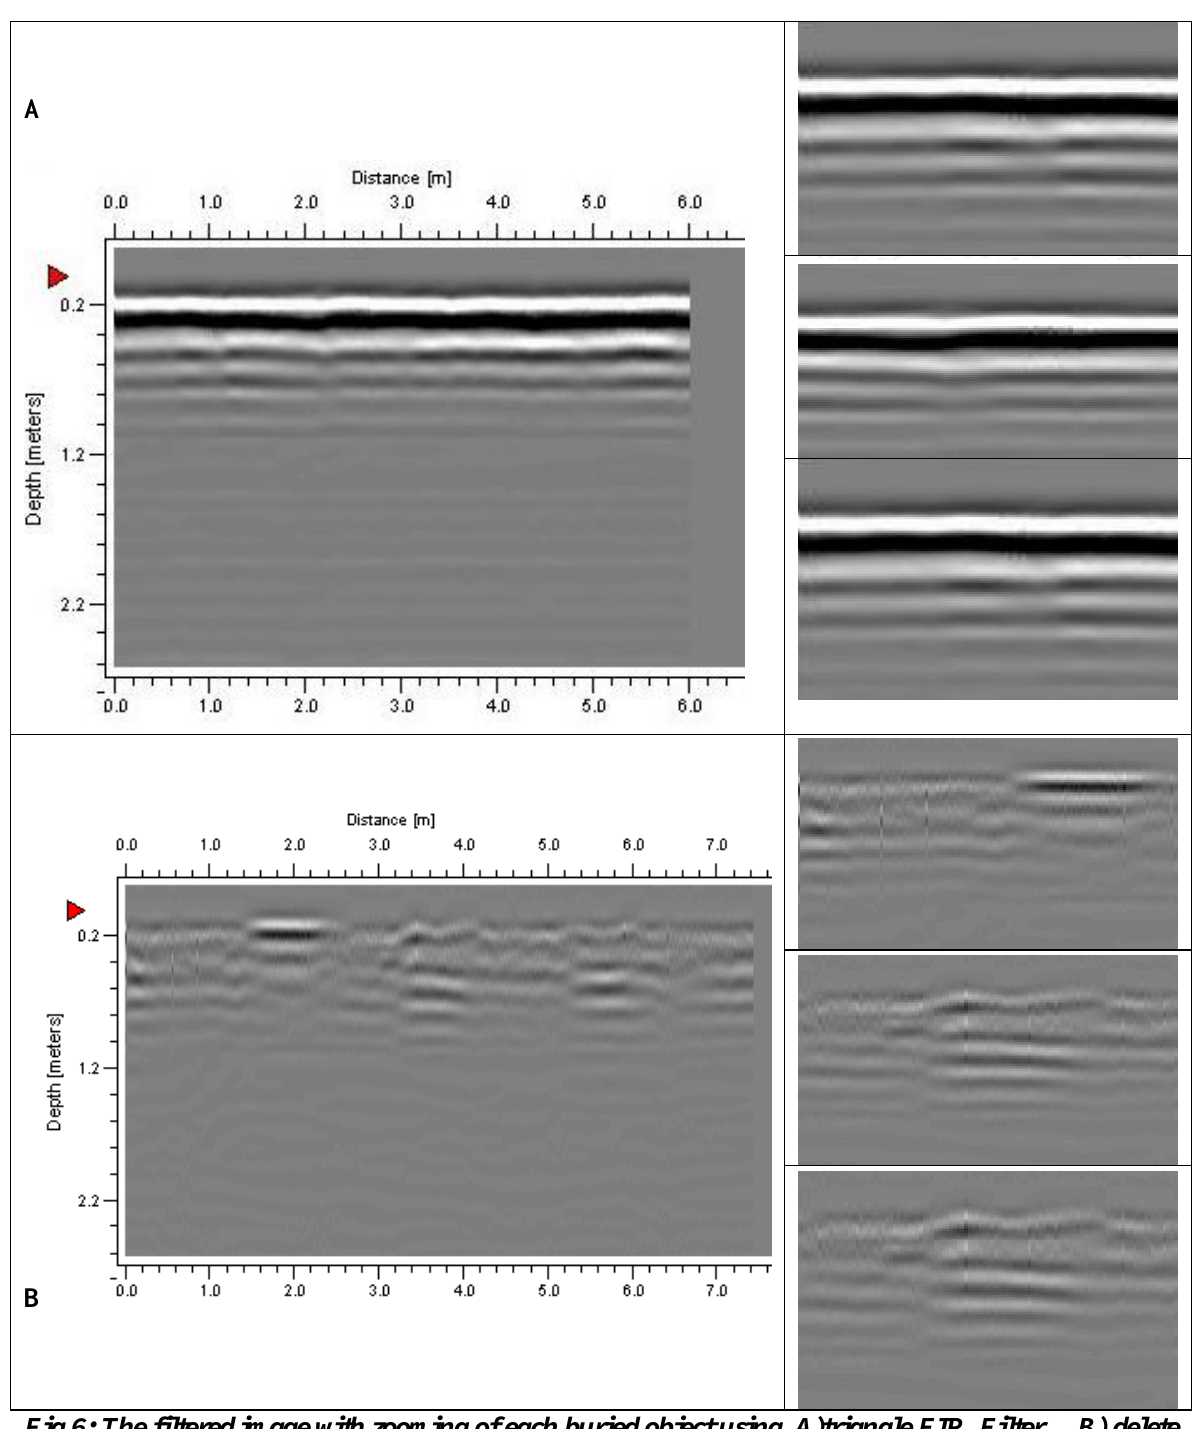
Fig.6: The filtered image with zooming of each buried object using A)triangle FIR. Filter, B) delete mean